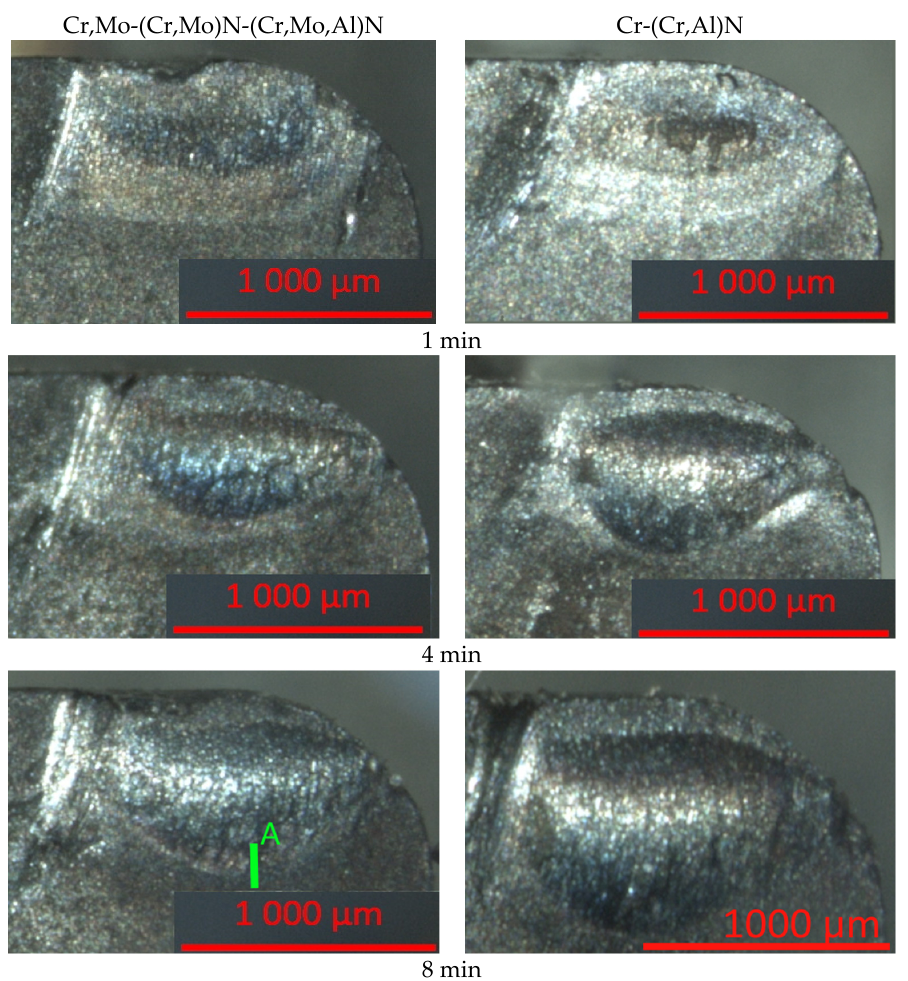
Figure 3. Wear dynamics on the rake face of carbide inserts with the Cr,Mo-(Cr,Mo)N-(Cr,Mo,Al)N coating and the reference coating of Cr-(Cr,Al)N. Localization of lamella A.